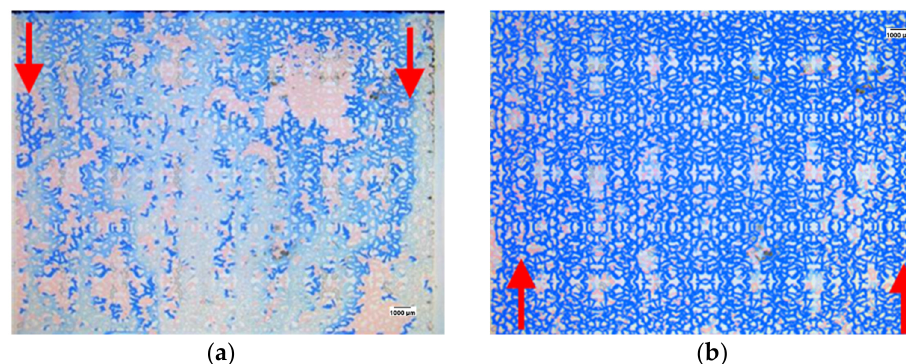
Figure 6. Emulsifier injection and subsequent water-invasion images of the homogeneous model: ( a ) the emulsifier is injected along the simulated “horizontal wellbore” and ( b ) the end of the second water flooding.